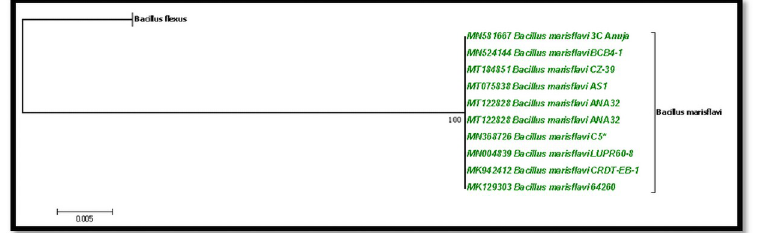
Fig 3. Molecular phylogenetic analysis by maximum likelihood method.